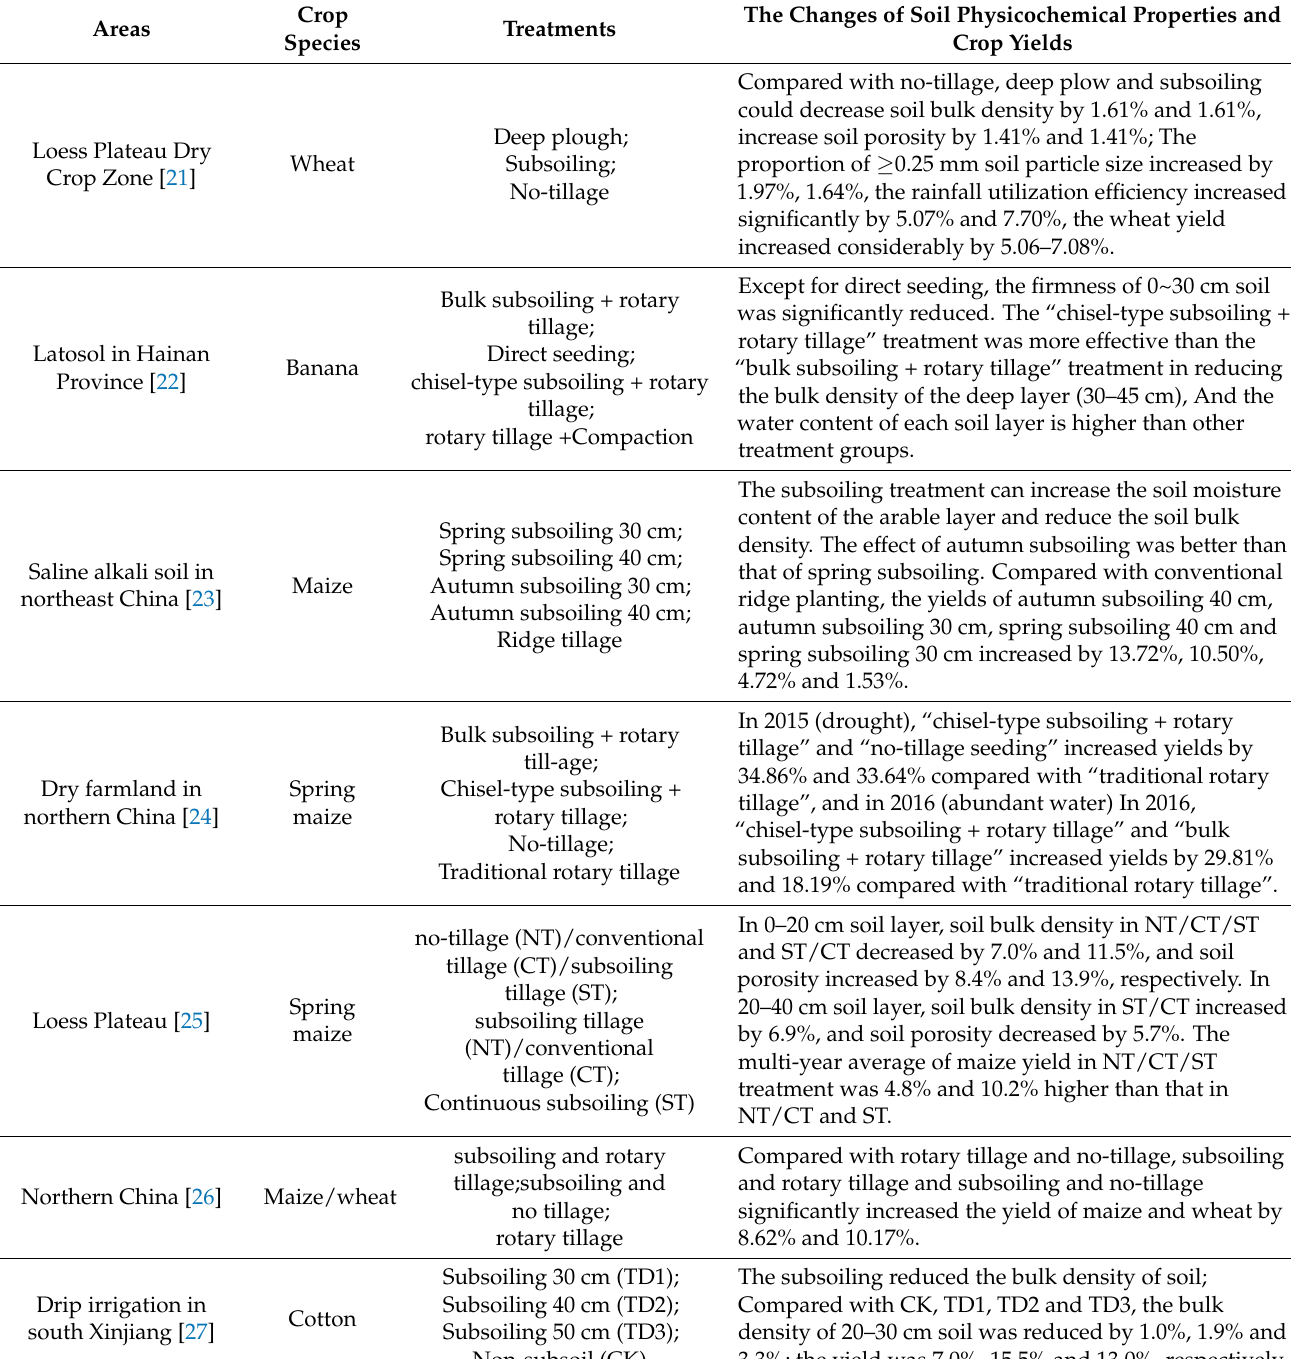
Table 2. Typical tillage treatments and the effect of each area in